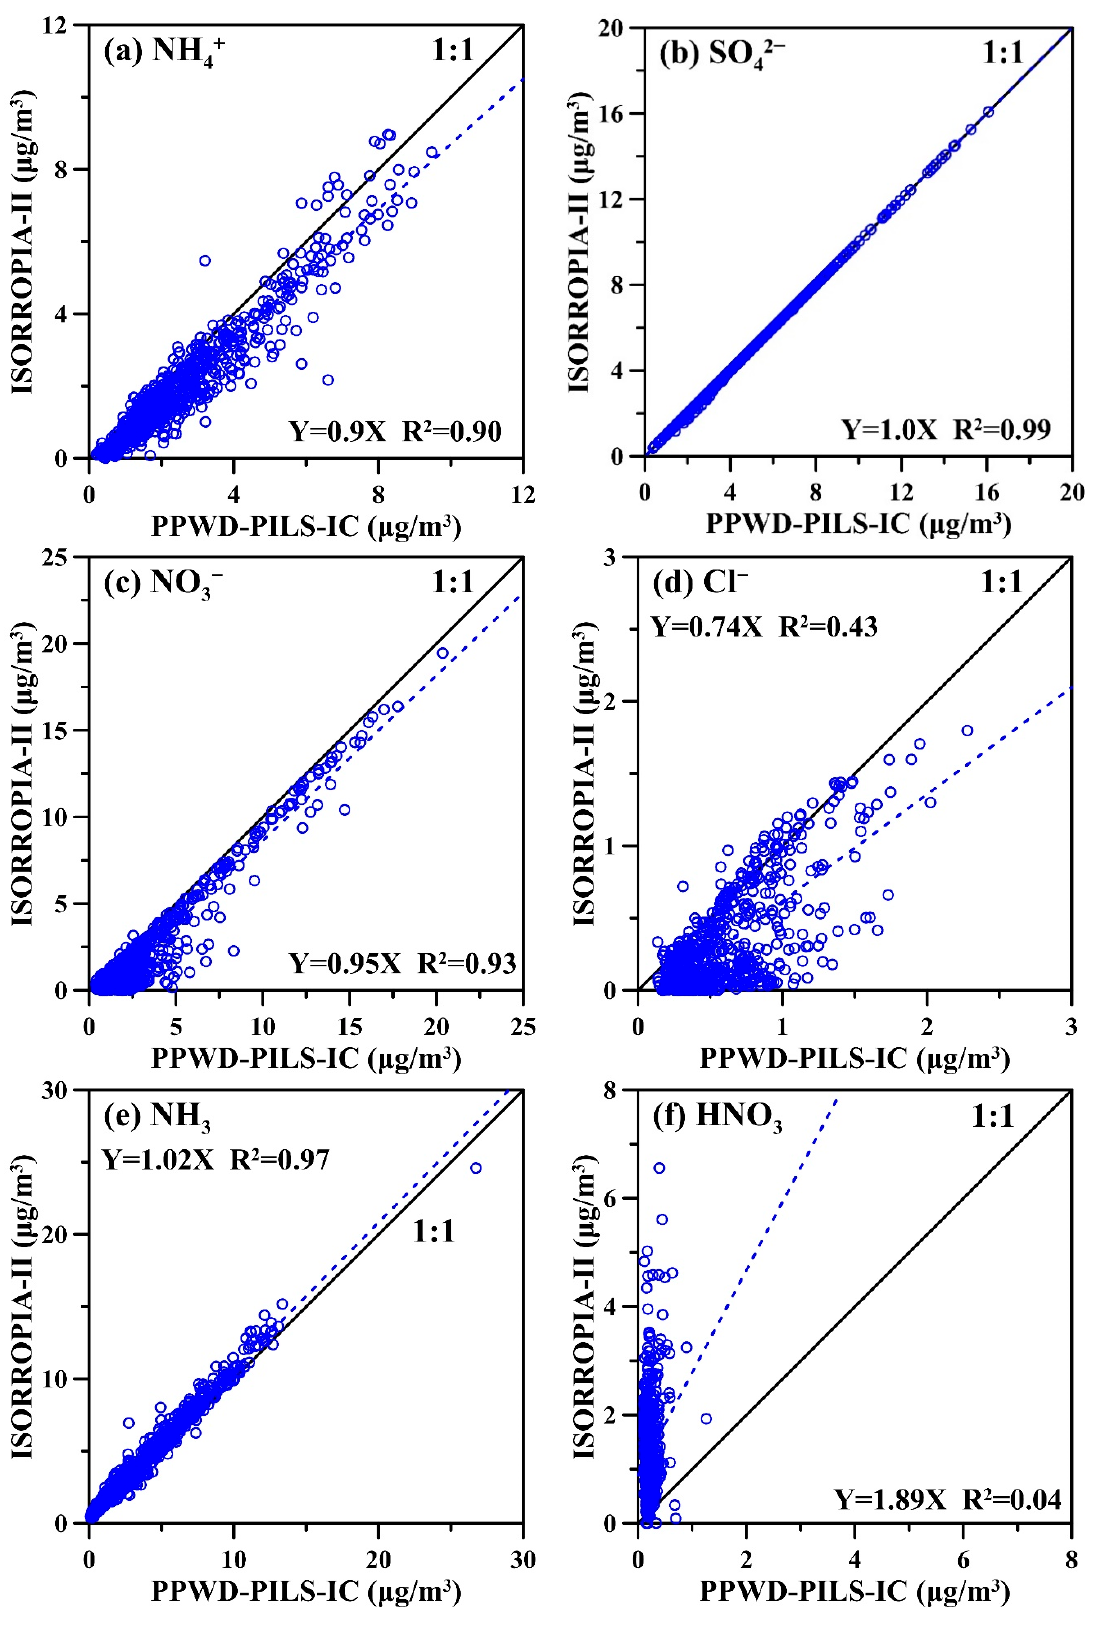
Figure 7. Correlation plot of the predicted results of ISORROPIA-II thermodynamic equilibrium model and the observed data of the PPWD-PILS-IC for ( a ) NH 4 + ; ( b ) SO 4 2 − ; ( c ) NO 3 − ; ( d ) Cl − ; ( e ) NH 3 ; and ( f ) HNO 3 when TN = [HNO 3 ] + [NO 3 − ].